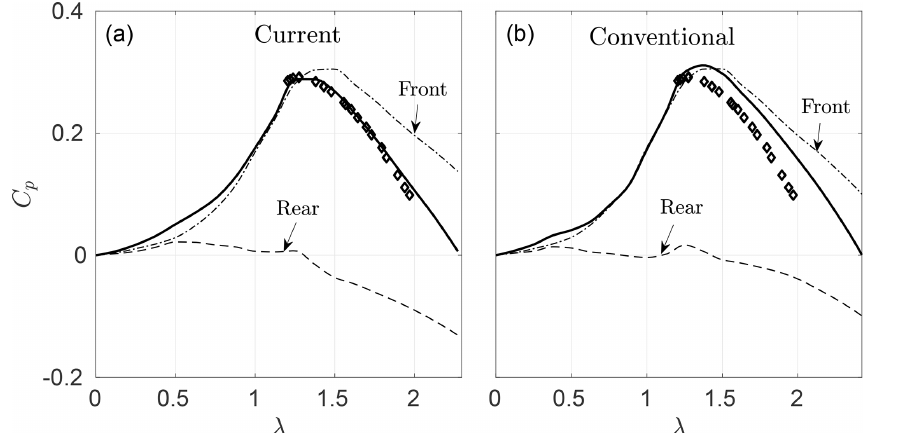
Figure 6. Comparison of current (a) and conventional (b) model predictions of power coefficients for the three-bladed VAWT. HRTF experimental data (diamonds) at Re D = 2 . 85 × 10 6 are plotted as a reference. Front and rear power contributions C p , f and C p , r are shown explicitly.